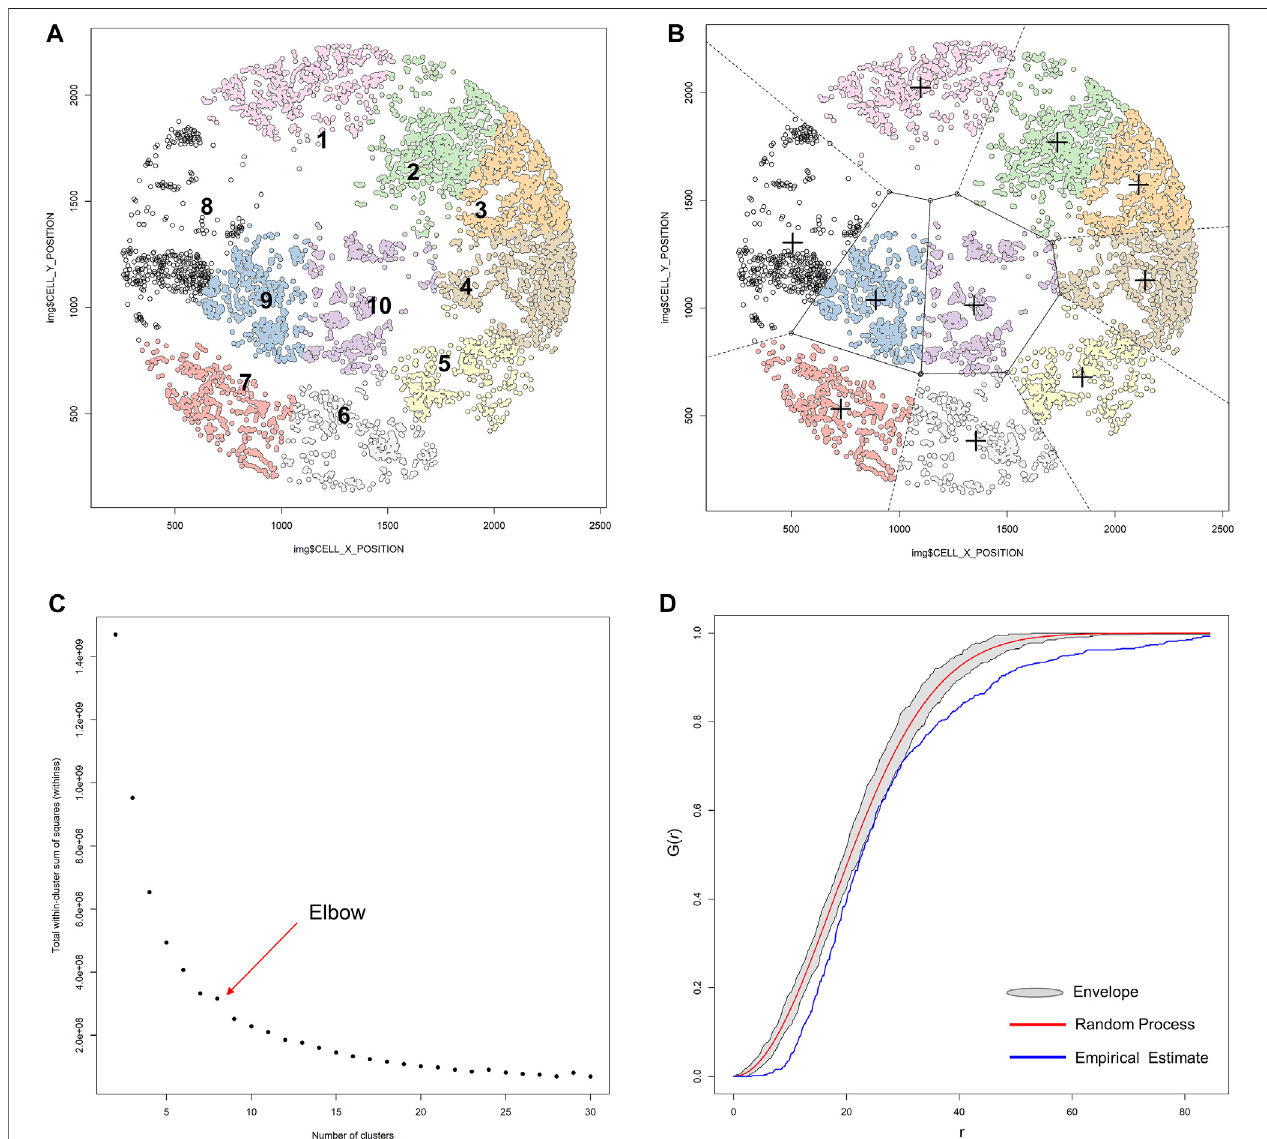
FIGURE 14 | K-means unsupervized clustering, elbow, and envelope applied in multiplex immuno fl uorescence image data. (A) K-means unsupervized clustering showingtengroups(representedbythecoloredpoints)ofnon-overlappingclustersinwhichtheinnerpointsoftheclusterareassimilaraspossiblewithintheimage. (B) Different clusters are maintained in different spaces, and the center ( + ) of each cluster is located such that it is the arithmetic mean of the data points in the cluster. (C) Graphic representation of the elbow method, showing the sum of squares and the number of clusters plotted into a curve. The point of the elbow in the curve indicates the optimum number of clusters. (D) Graphic representation of an envelope to estimate the variation of data to achieve ef fi ciency gains, showing the minimal variation of the envelope related to the random process curve from a representative sample of multiplex immuno fl uorescence data points. The graphics were generated using R studio software version